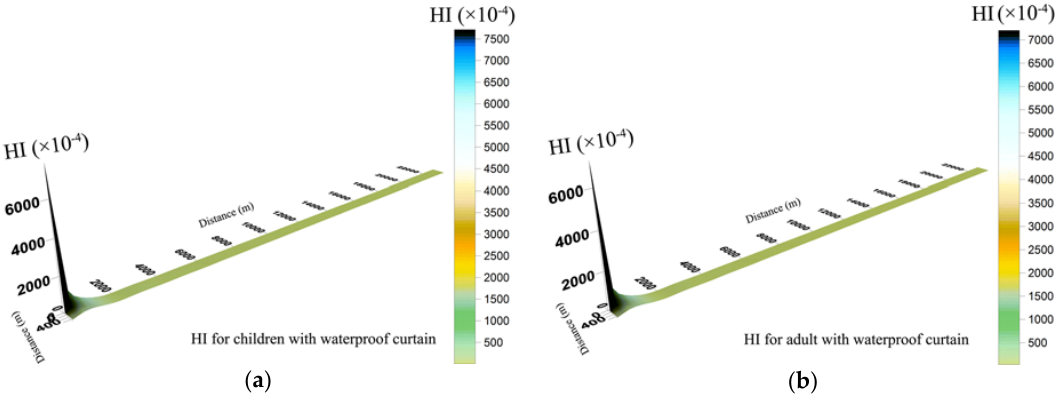
Figure 4. Spatial distribution of hazard index (HI) for children ( a ) and adults ( b ) during groundwater leakage with a waterproof curtain.